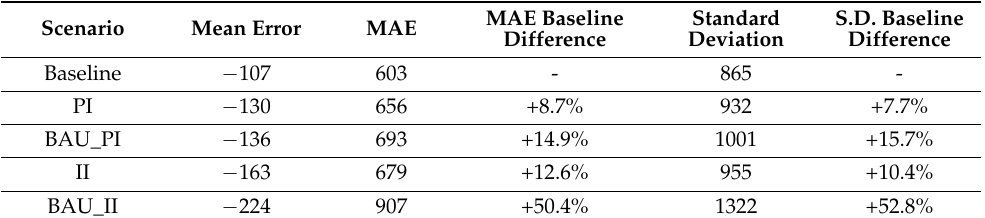
Table 7. Aggregate (i.e., national) day ahead errors (MW) for onshore wind, offshore wind and wave, showing that geographic diversity reduces forecasting errors.